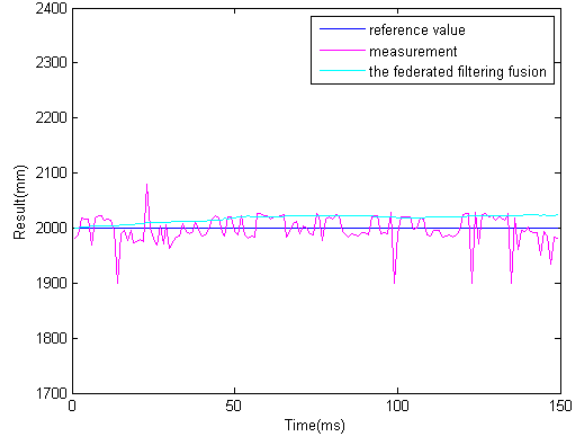
Figure 19. The results of information fusion based on an adaptive Kalman filter using binocular cameras and two ultrasonic sensors at 2.0 m.